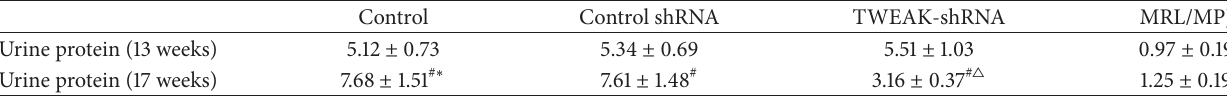
Table 1: Proteinuria in MRL/MPJ and MRL/lpr mice (mg/24